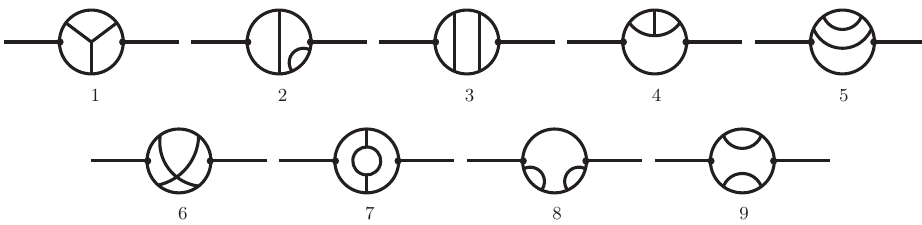
Figure 6. Self-energy topologies contributing to the three-loop corrections to the Higgs boson mass at order O( y 6 ) in the SM. Topology 6 is the only non-planar self-energy. t The external lines of the topologies contain only the Higgs field ( h ). The internal lines (propagators) contain the top quark ( t ), bottom quark ( b ), Higgs and Goldstone bosons ( G 0 , and G ± ) fields. The cubic vertices involved in the computation are hht , G 0 G 0 t , and G ± tb . In the Landau gauge, therefore, the Feynman integrals contain four different